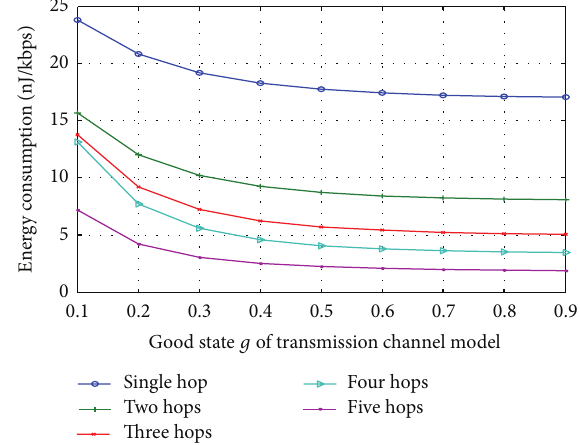
Figure 12: The average amount ofenergy required to report an event under integer optimization